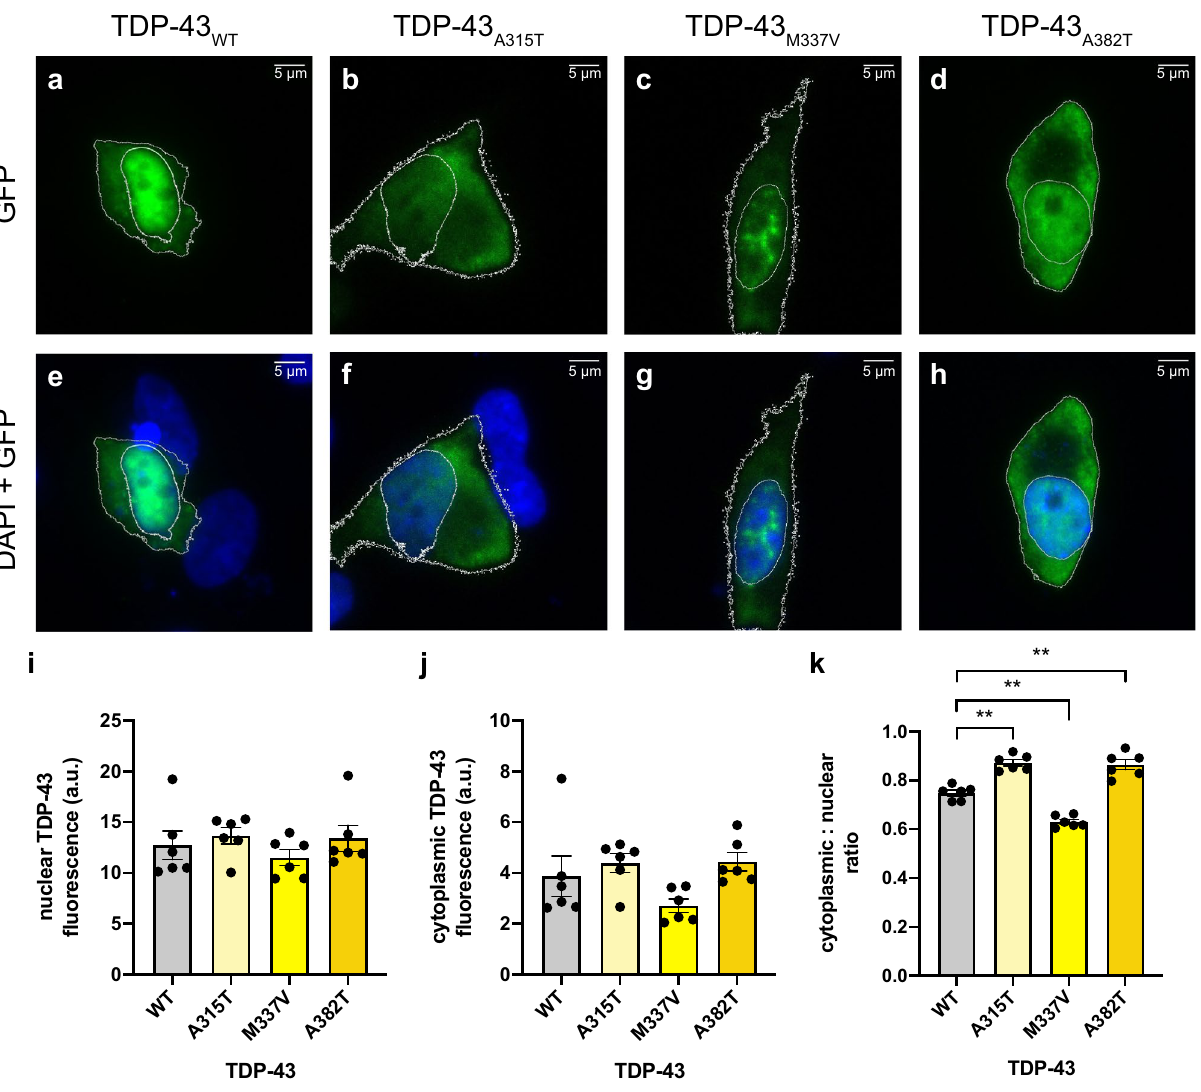
Figure 3. Detection of TDP-43 cytoplasmic mislocalisation with exogenous expression of TARDBP mutations. Representative images of SH-SY5Y cells overexpressing GFP-tagged ( a , e ) TDP-43 WT , ( b , f ) TDP-43 A315T , ( c , g ) TDP-43 M337V or ( d , h ) TDP-43 A382T . Nuclei were visualised with DAPI (blue). ( i ) Quantification of the fluorescence intensity of the nucleus and ( j ) the cytoplasm shows no significant difference in TDP-43 expression. ( k ) Quantification of the cytoplasmic/nuclear ratio of exogenous TDP-43 shows a significant increase in TDP- 43 A315T and TDP-43 A382T , and a decrease in TDP-43 M337V , when compared to cells expressing TDP-43 WT . Scale bars = 5 μm. Data is represented as mean ± SEM. a.u. arbitrary units. **p <